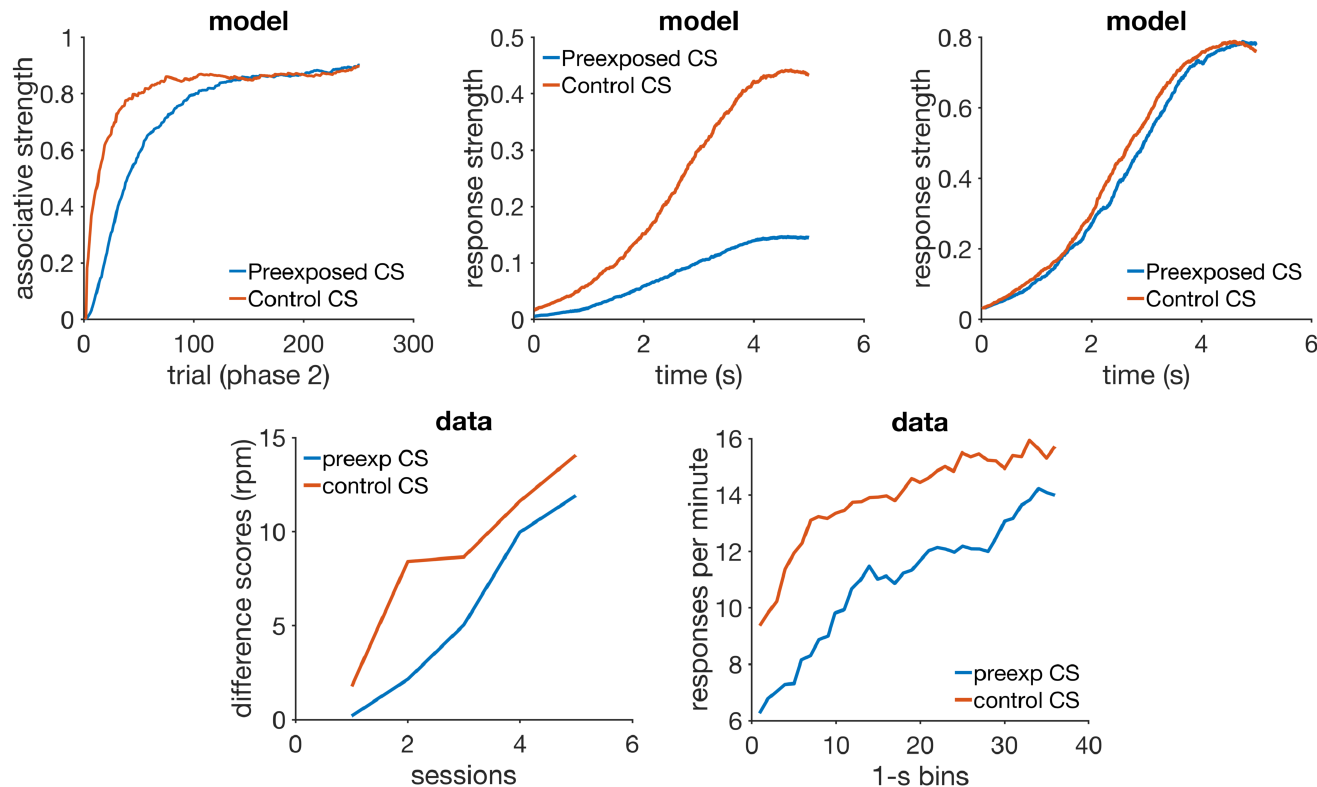
Fig 6. Latent inhibition. Top row: simulatedassociativestrength in latent inhibition(left), simulatedCR averaged over the first 30 trials of conditioning phase (middle), and simulatedCR averagedover the last 30 trials of conditioningphase(right). Bottom row: acquisitioncurves from an actual experiment in latent inhibition(left), and responserate data duringthe CS (right). Data plots redrawn from Figures 1 and 2 respectivelyin [70]. Model parameters: α t = 0.1, α V = 0.08, μ = 1, σ = [0.6 − 0.35], m = 0.2, H = 4, α PH = 0.4, γ = 0.03.